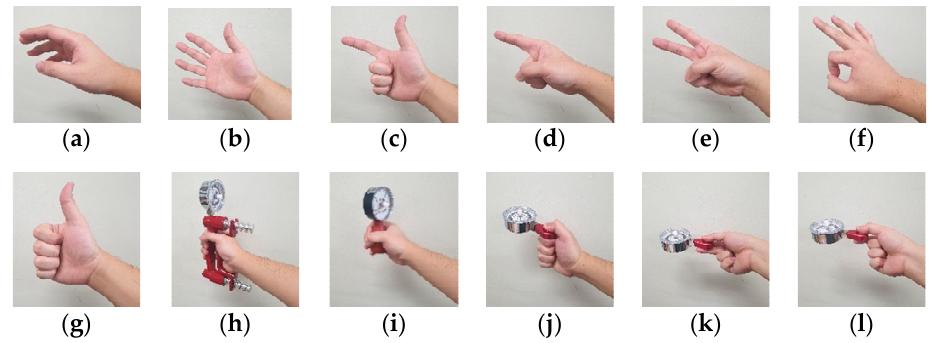
Figure 2. Twelve hand postures selected for use in this study: ( a ) rest, ( b ) spread, ( c ) scissor-sign, ( d ) finger pointing, ( e ) V-sign, ( f ) O.K.-sign, ( g ) thumb-up (hook), ( h ) cylindrical grasp, ( i ) spherical grasp, ( j ) lateral pinch, ( k ) palmar pinch, ( l ) tip pinch